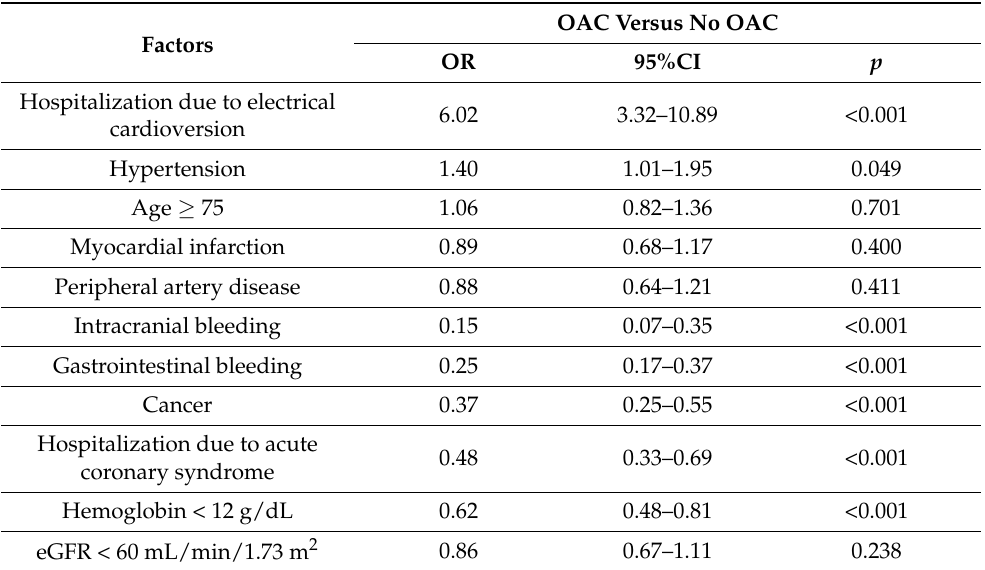
Table 2. Factors associated with the selection of an OAC over no OAC for stroke prevention in AF patients: multivariable logistic regression